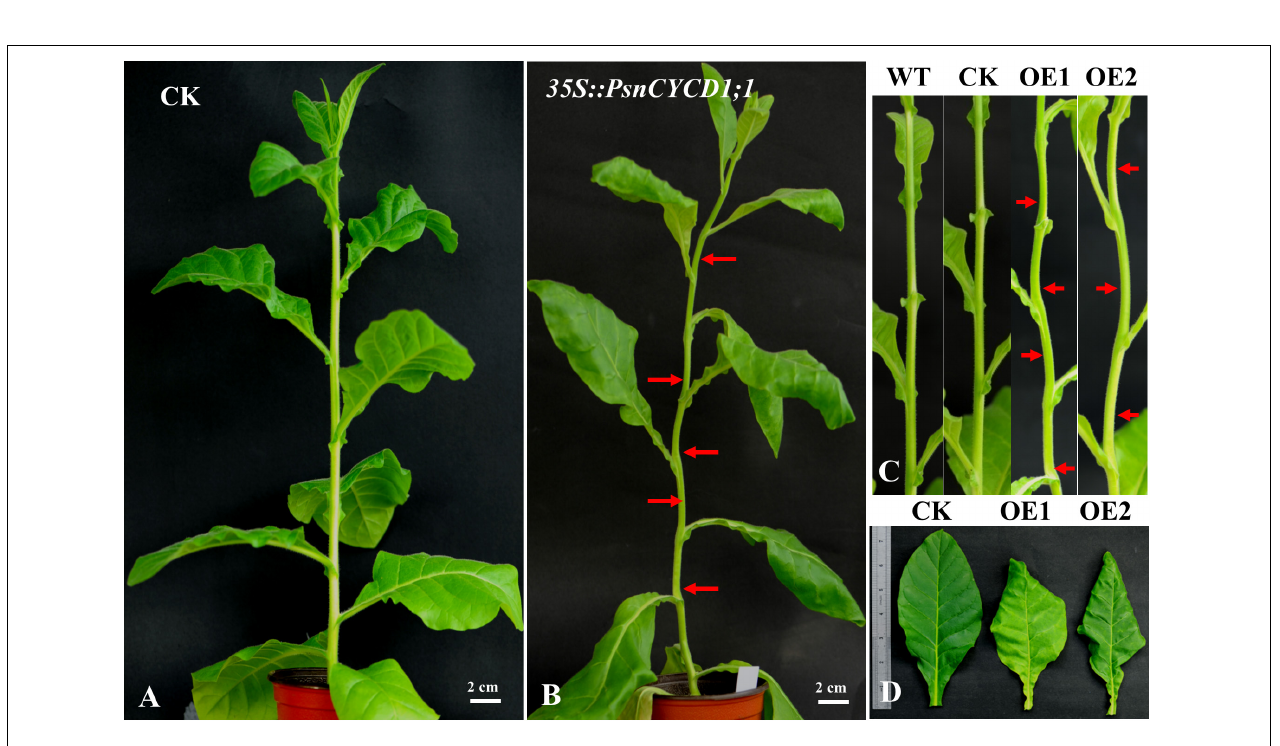
Frontiers in Plant Science |